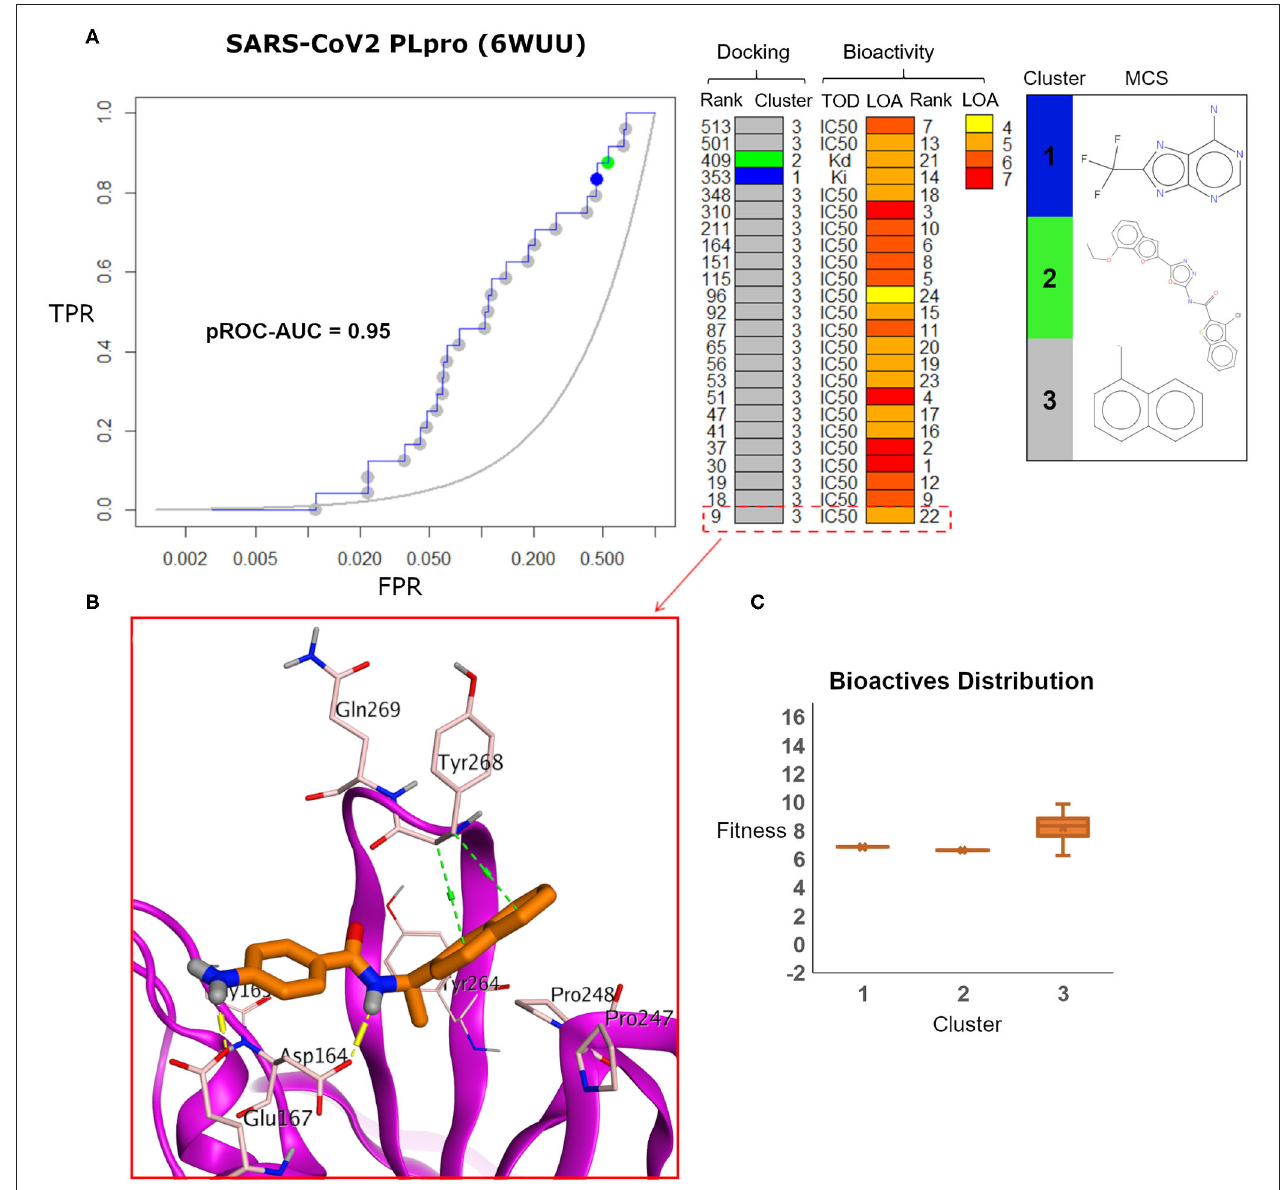
FIGURE 8 | (A) pROC-Chemotype plot of SARS-CoV-2 PLpro (PDB ID: 6WUU) using the FRED docking tool. The docking information is matched with the chemotype represented by the cluster number and the bioactivity information. (B) The best enriched bioactive compound in the binding site of the protein. (C) Box plot of the fitness vs. chemotype clusters illustrating the bioactive molecules